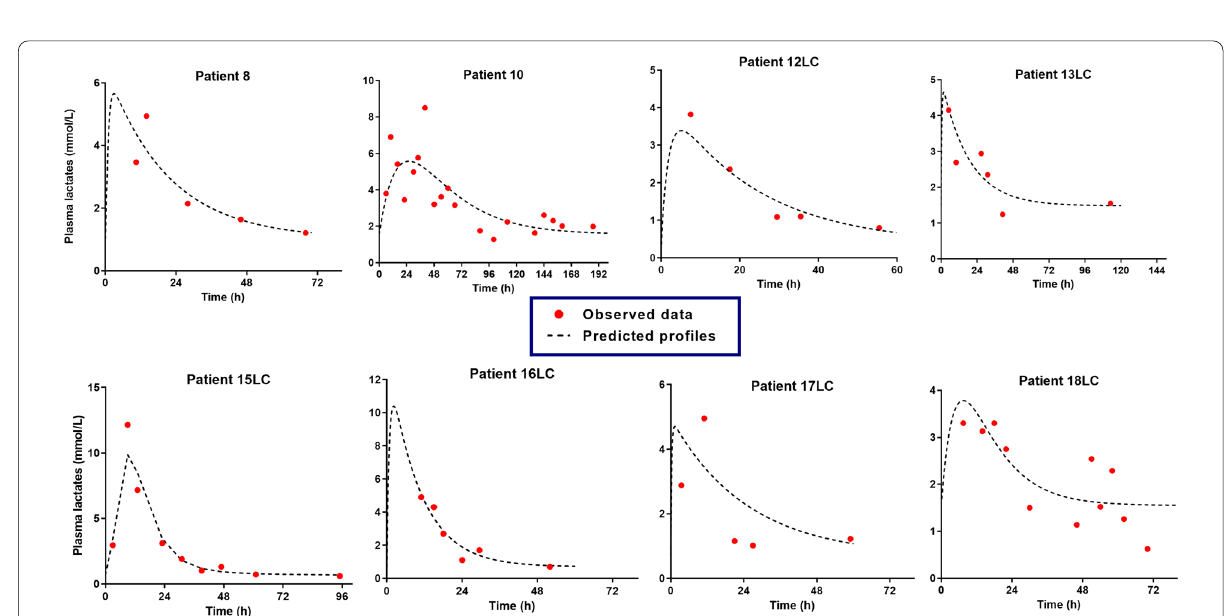
Fig. 4 Individual time-course of blood lactate concentrations in eight valproic acid-poisoned patients. LC means treated with